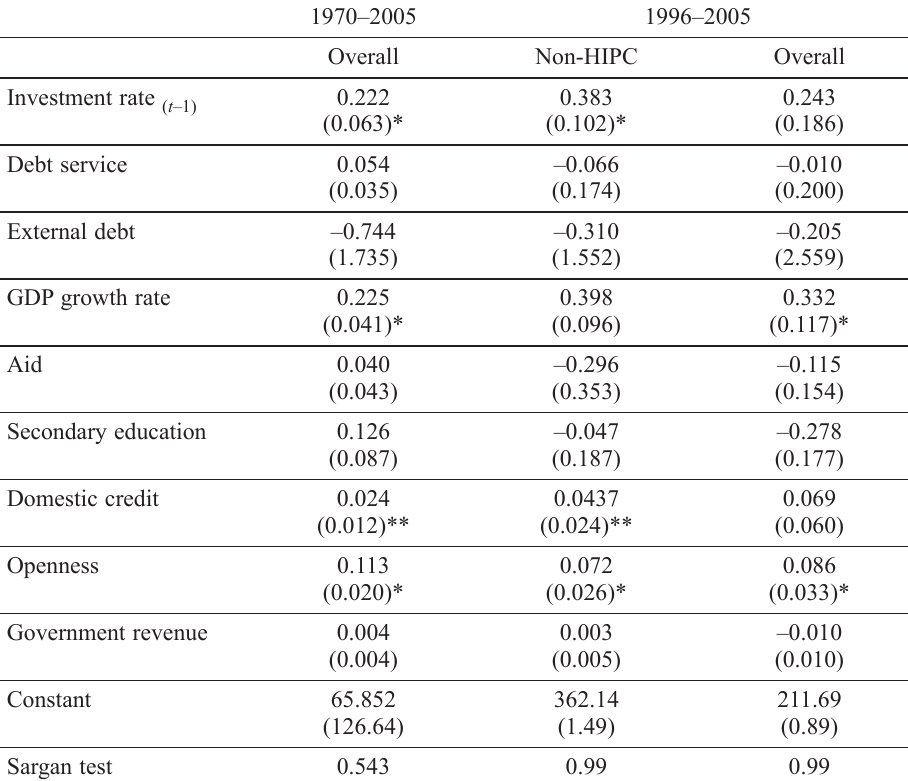
Table 5. The impact of external debt in investment